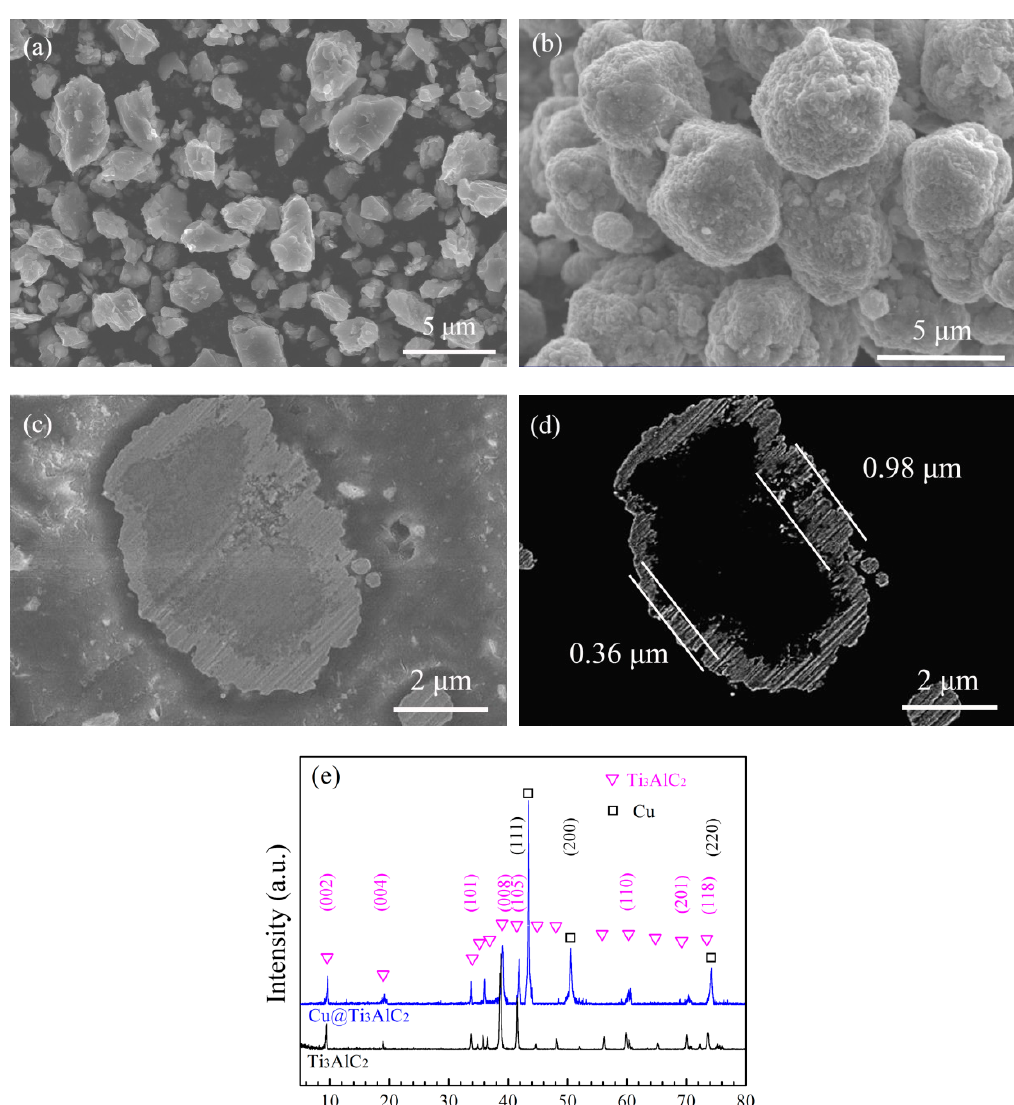
Figure 3. The Ti 3 AlC 2 powder particles before and after electroless Cu plating: ( a ) and ( b ) the morphology of Ti 3 AlC 2 powder and Cu@Ti 3 AlC 2 powder; ( c ) and ( d ) the profile of the Cu@Ti 3 AlC 2 powder; ( e ) the XRD patterns of Ti 3 AlC 2 powder and Cu@Ti 3 AlC 2 powder.